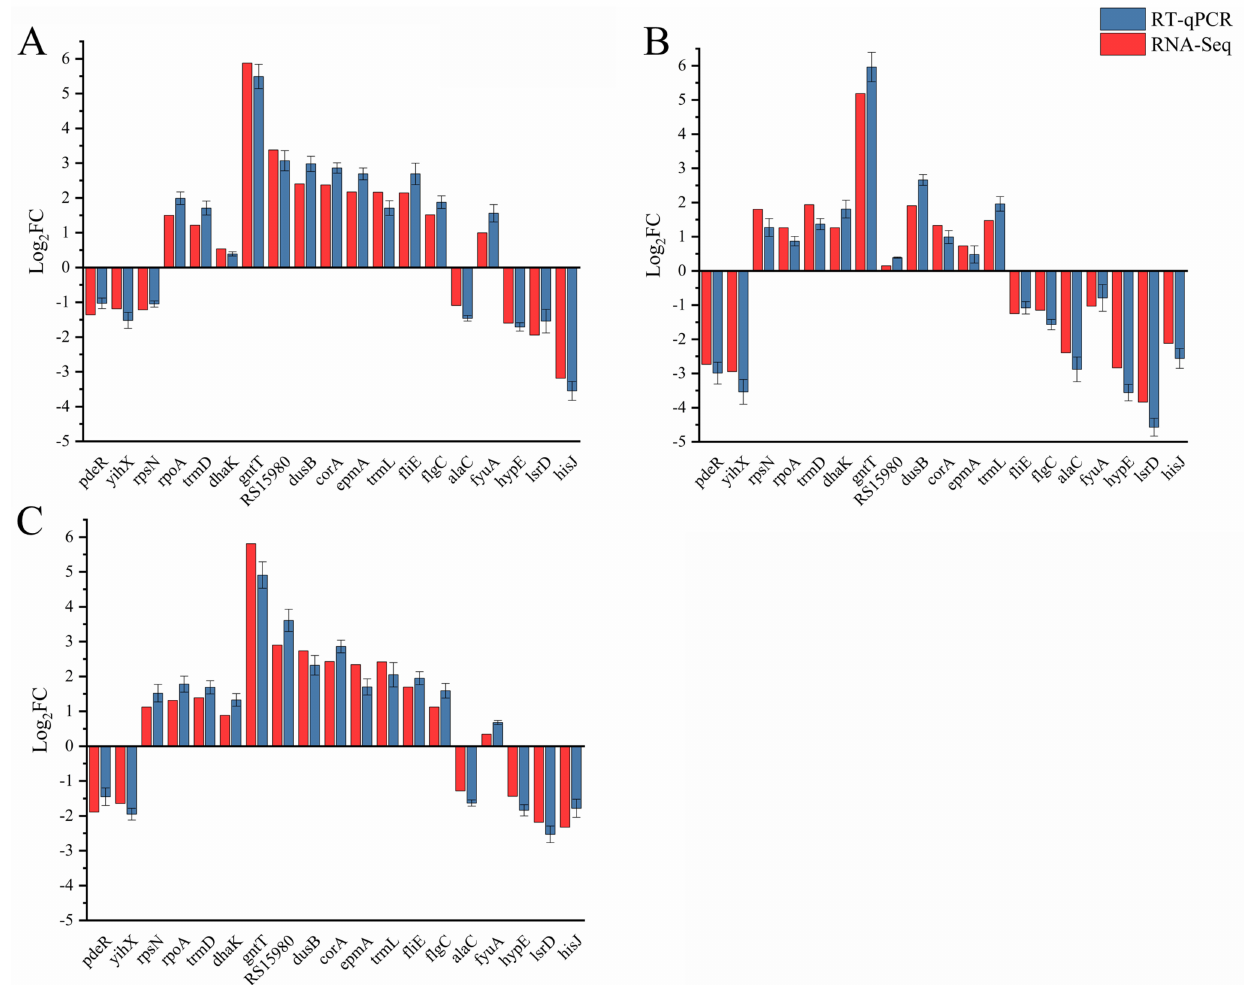
Figure 3. Validation of candidate DEGs by RT-qPCR. ( A ) Gene transcription in ∆ dksA . ( B ) Gene transcription in ∆ relA ∆ spoT . ( C ) Gene transcription in ∆ dksA ∆ relA ∆ spoT . The data are the means and SEM from three independent